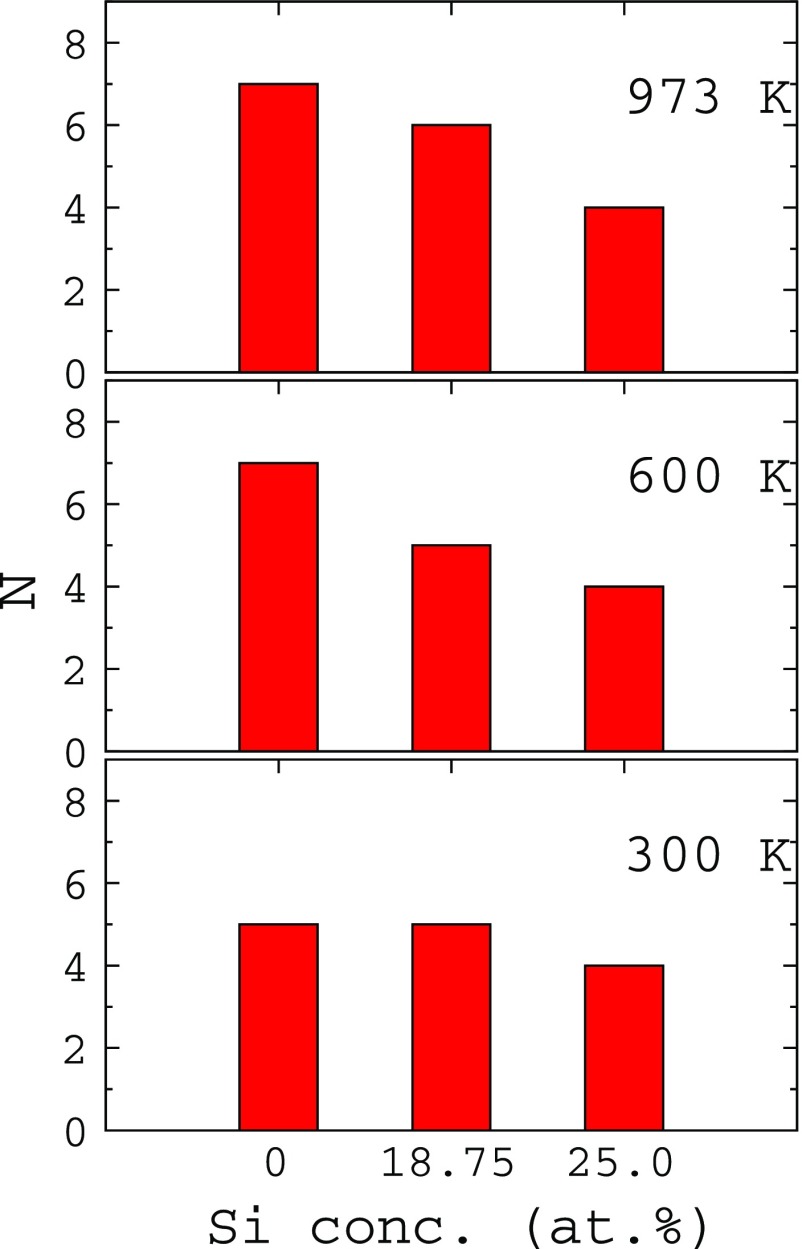
The variation of the number of oxygen atoms (N) in between the first and second layers of the Ti(0 0 0 1) surface with the Si concentration and temperature. The plot is for θ = 1.0 ML.